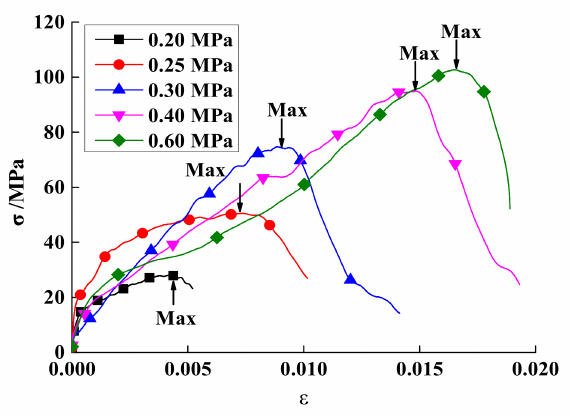
Figure 6. Stress–strain curves of mudstone samples, for different impact pressure.